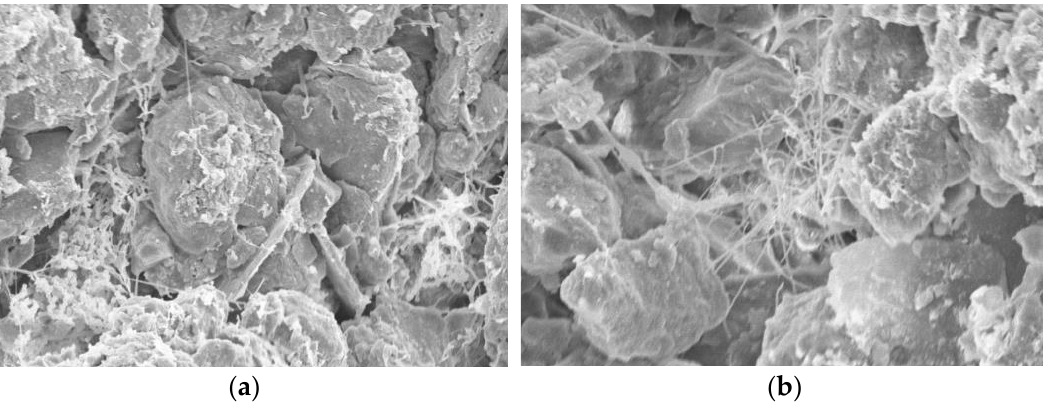
Figure 5. Lignosulfonate-modified loess reticular structures at the stated magnifications [46]. ( a ) 500 × ; ( b ) 800 × .